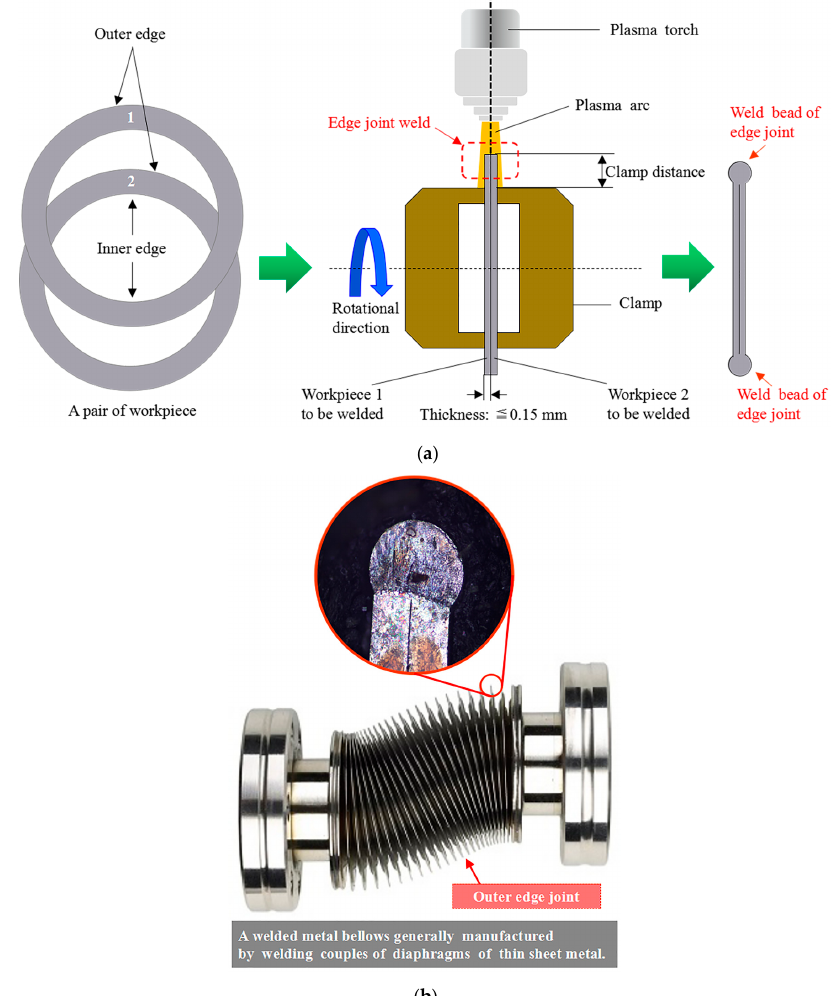
Figure 1. The schematic diagram for the micro-plasma arc welding of edge weld in an ultra-thin sheets edge joint: ( a ) Two-dimensional view of the edge welding; ( b ) An example of the edge-welded metal bellows using micro-plasma arc welding (MPAW).